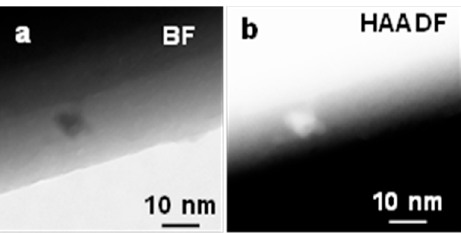
Figure 7. ( a ) Bright field (BF) ( b ) high-angle annular dark-field (HAADF) STEM images of Ag NPs at the interface of Ga 2 O 3 nanowire growth on quartz substrate at 1000 °C. The NP was bright due to z- contrast.